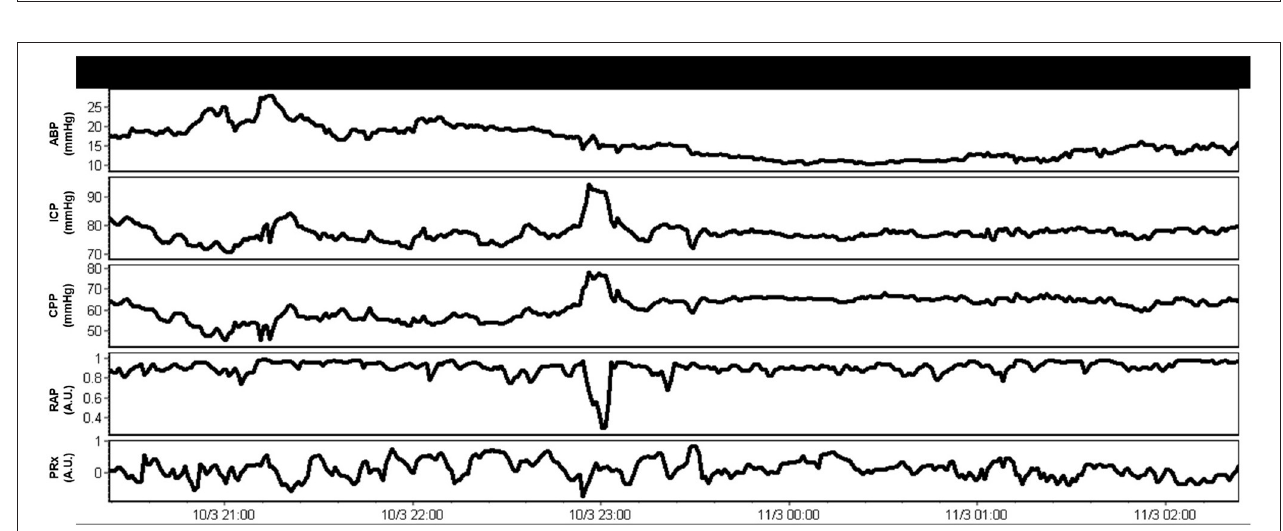
FIGURE 2 | Example of combined raw and derived continuous multi-modal monitoring metrics in moderate/severe TBI. These derived continuous parameters can be computed in real time and made available to the treating clinician to help tailor management. A.U., arbitrary units; ABP, arterial blood pressure; CPP, cerebral perfusion pressure; ICP, intracranial pressure; mmHg, millimeters of Mercury; PRx, pressure reactivity index for cerebrovascular reactivity monitoring (moving correlation between ICP and ABP); RAP, compensatory reserve index (moving correlation between ICP and pulse amplitude of ICP). Data taken from previously published and